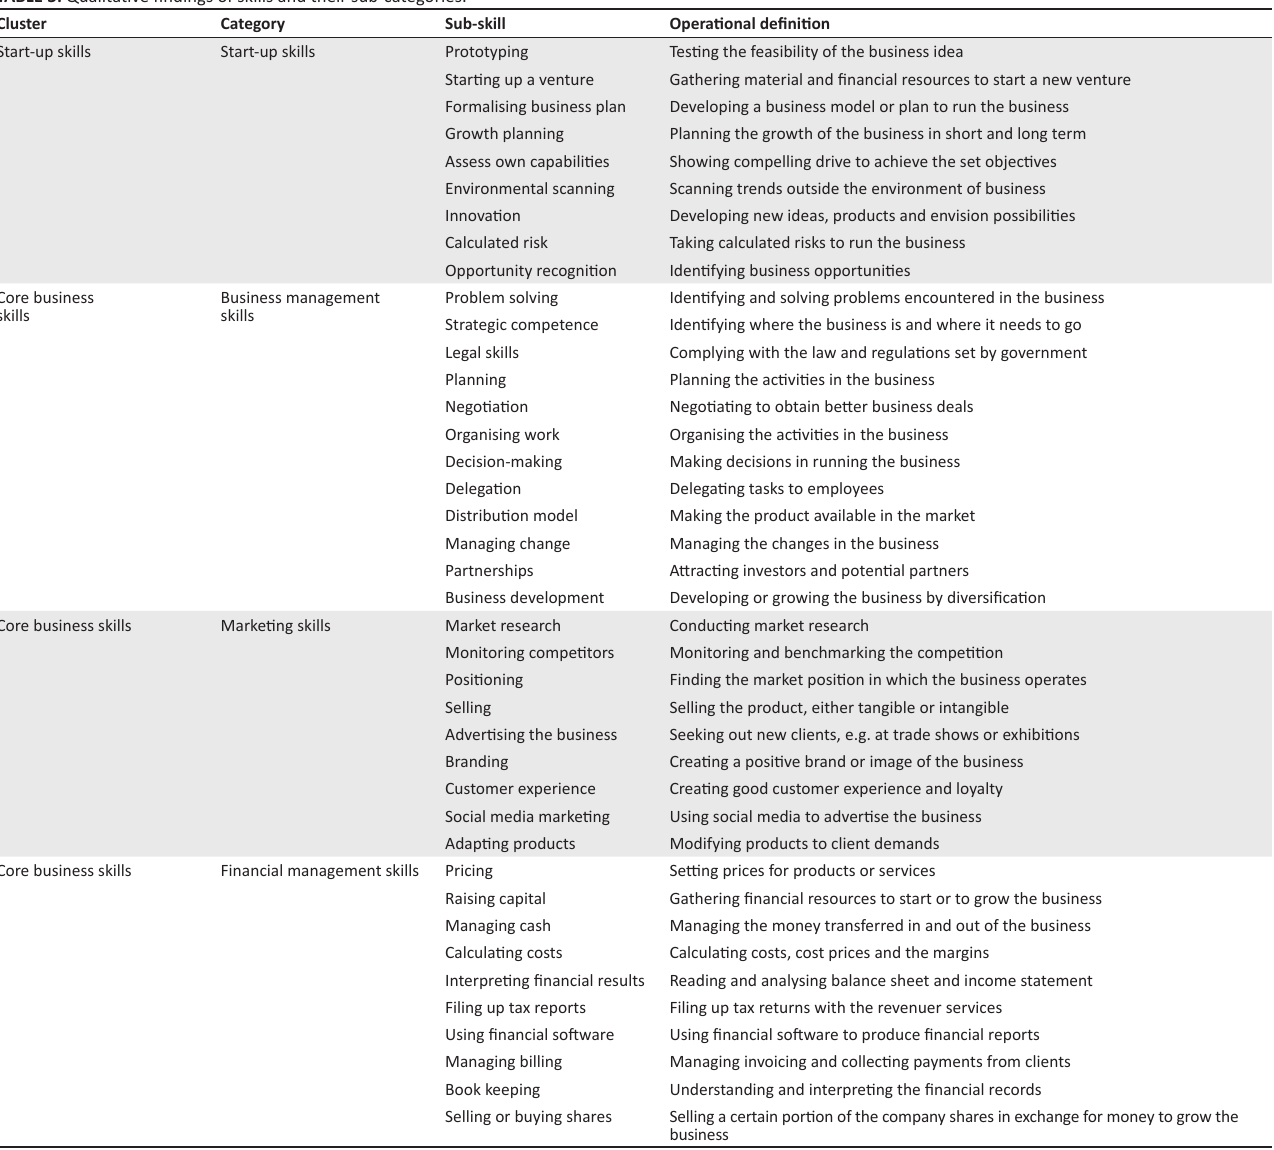
TABLE 3: Qualitative findings of skills and their